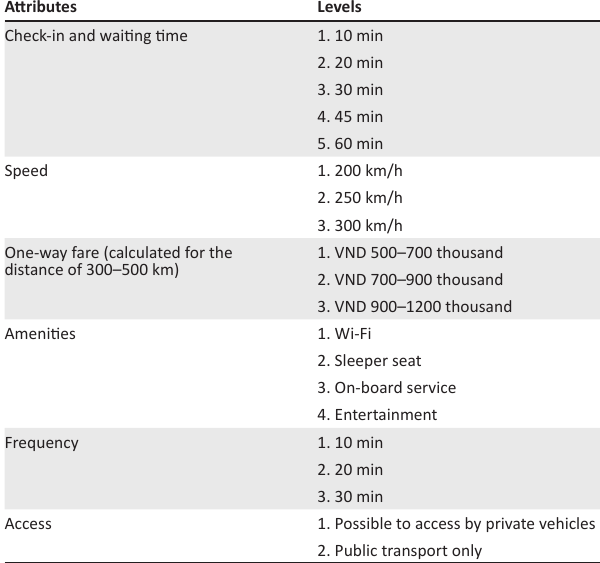
TABLE 2: List of attributes and levels used in the choice experiment. Attributes